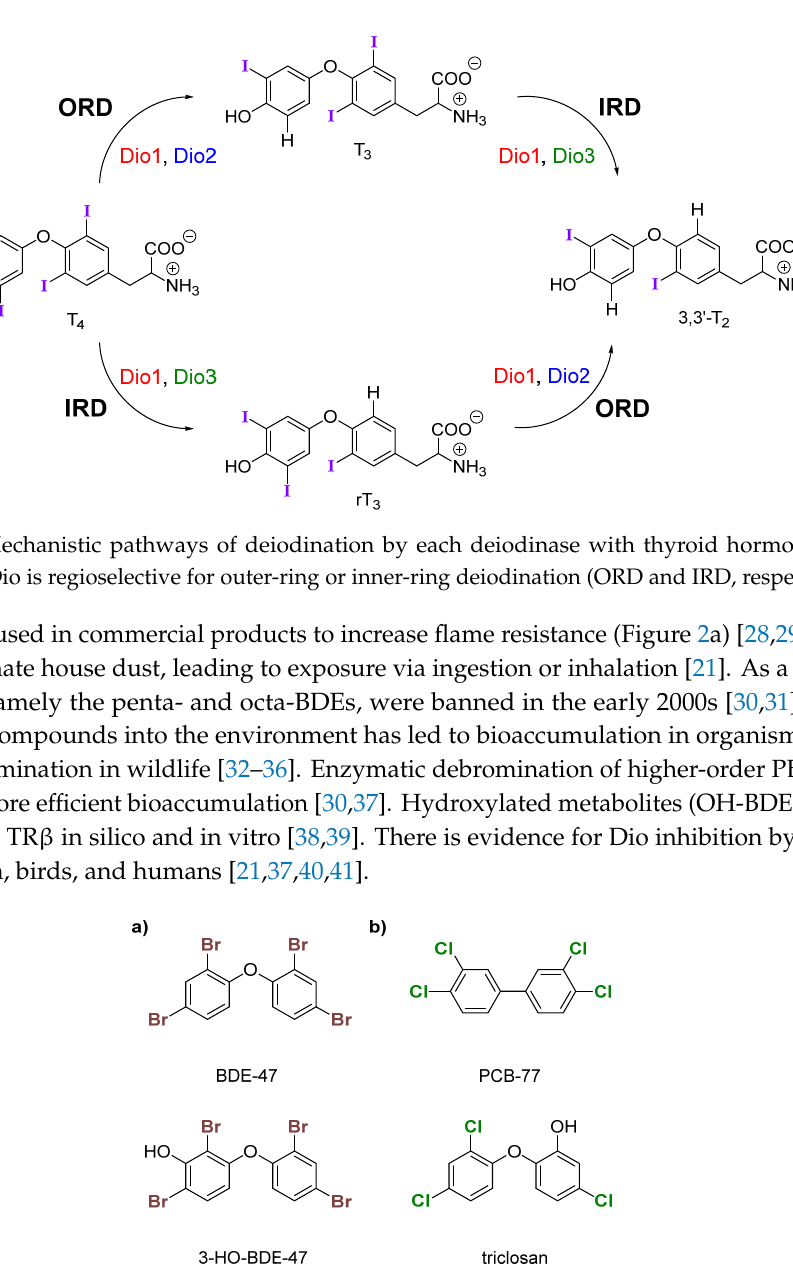
Figure 2. Examples of ( a ) polybrominated diphenyl ethers (PBDEs)—BDE-47 and 3-HO-BDE-47; ( b ) polychlorinated biphenyls (PCBs)—PCB-77 and